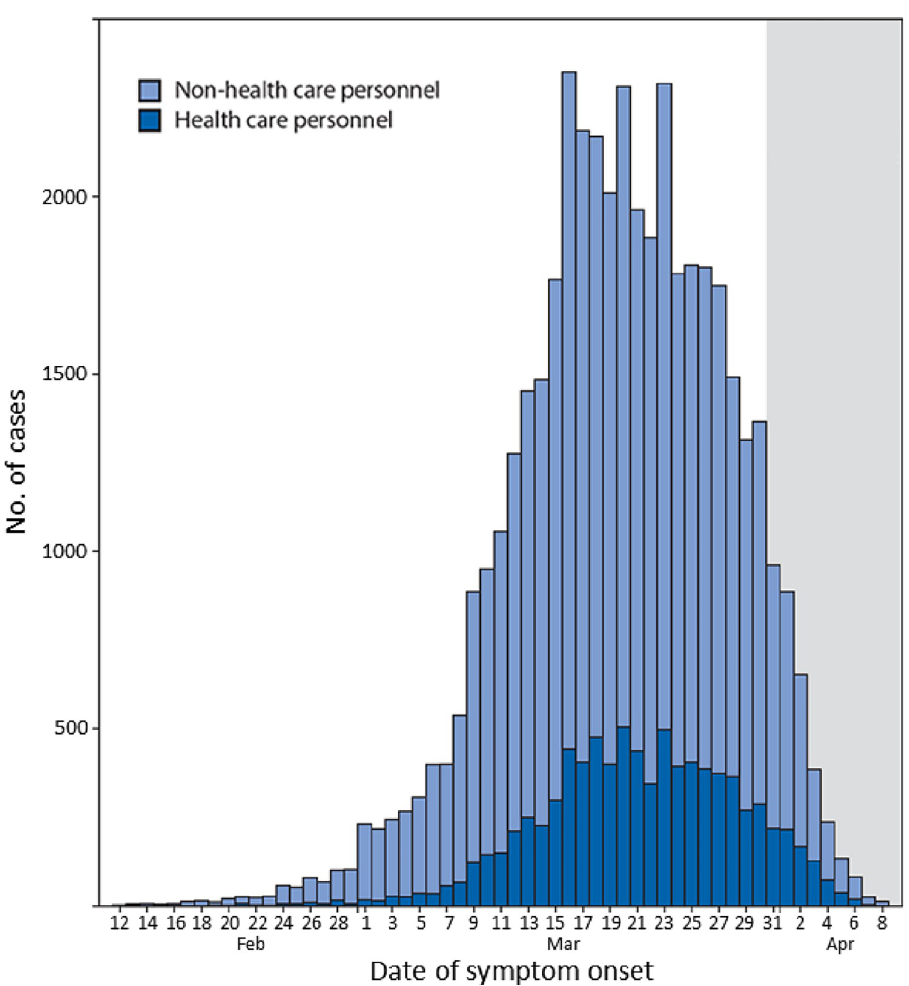
Fig 4. Daily number of laboratory-confirmed positive COVID-19 cases by date of symptom onset of health care personnel and non-health care personnel (N = 43968) in the US from February 12 to April 9, 2020 [47].